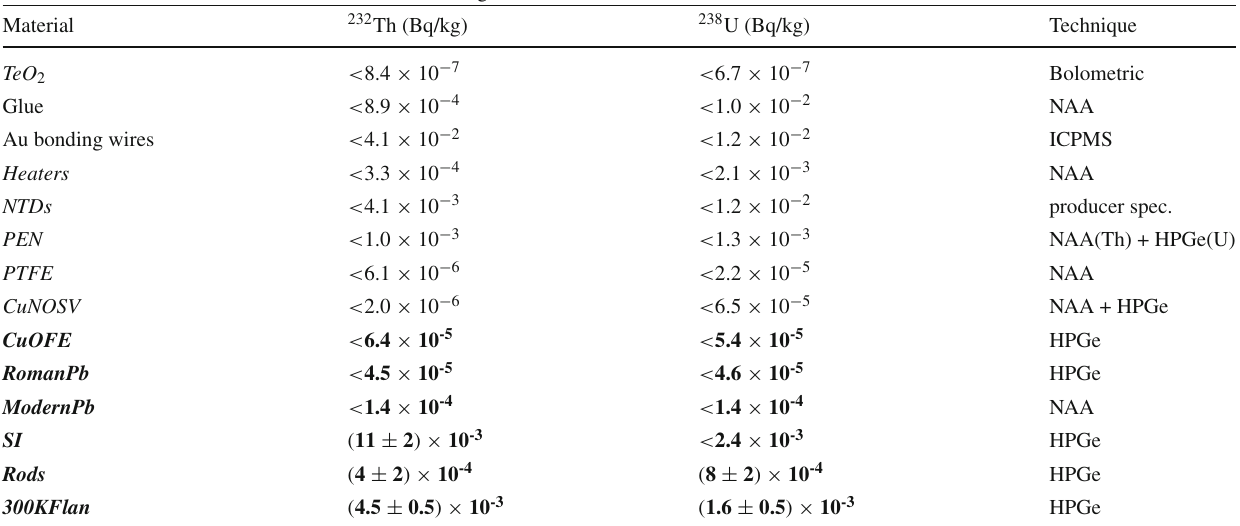
Table 3 Values and 90% C.L. (95% C.L. for HPGe measurements) upper limits on 232 Th and 238 U bulk contaminations of detector and cryostat materials (the various components are described in Section 2), asobtainedinthematerialscreeningcampaign.Activitiesareexpressed in Bq/kg (1 Bq/kg = 246 × 10 − 9 g/g for 232 Th and 81 × 10 − 9 g/g for